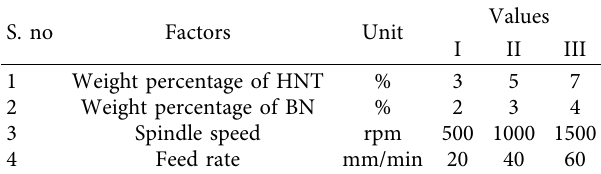
Table 3: Control parameters and corresponding levels.